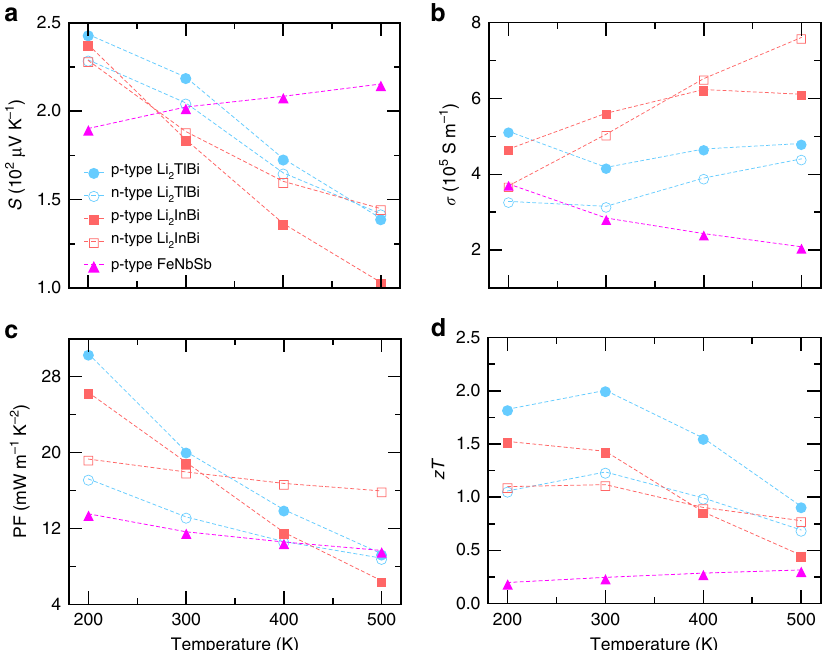
Fig. 5 Electron transport properties. a – d The Seebeck coef fi cient S ( a ), electrical conductivity σ ( b ), power factor PF ( c ), and zT ( d ) of Li 2 TlBi and Li 2 InBi at carrier concentrations that give rise to maximum zT at 200, 300, 400, and 500 K, compared with p-type FeNbSb. The lattice thermal conductivity of FeNbSb used to compute zT is extracted from ref. 36 . The electronic thermal conductivity ( κ e ) is shown in Supplementary Figs. 4 and 5